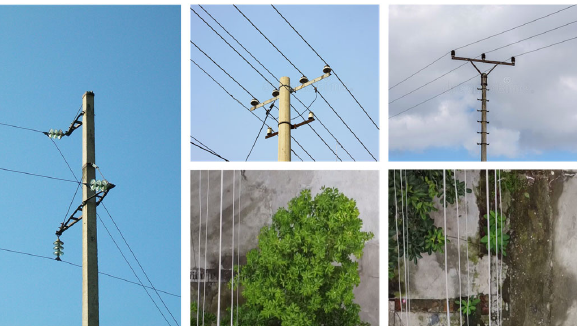
Figure 5. Samples from the proposed dataset. The dataset includes transmission lines and power- lines, and some of the images are from the Internet. The dataset uses images taken from the drone’s perspective, which can be used for subsequent positioning and other